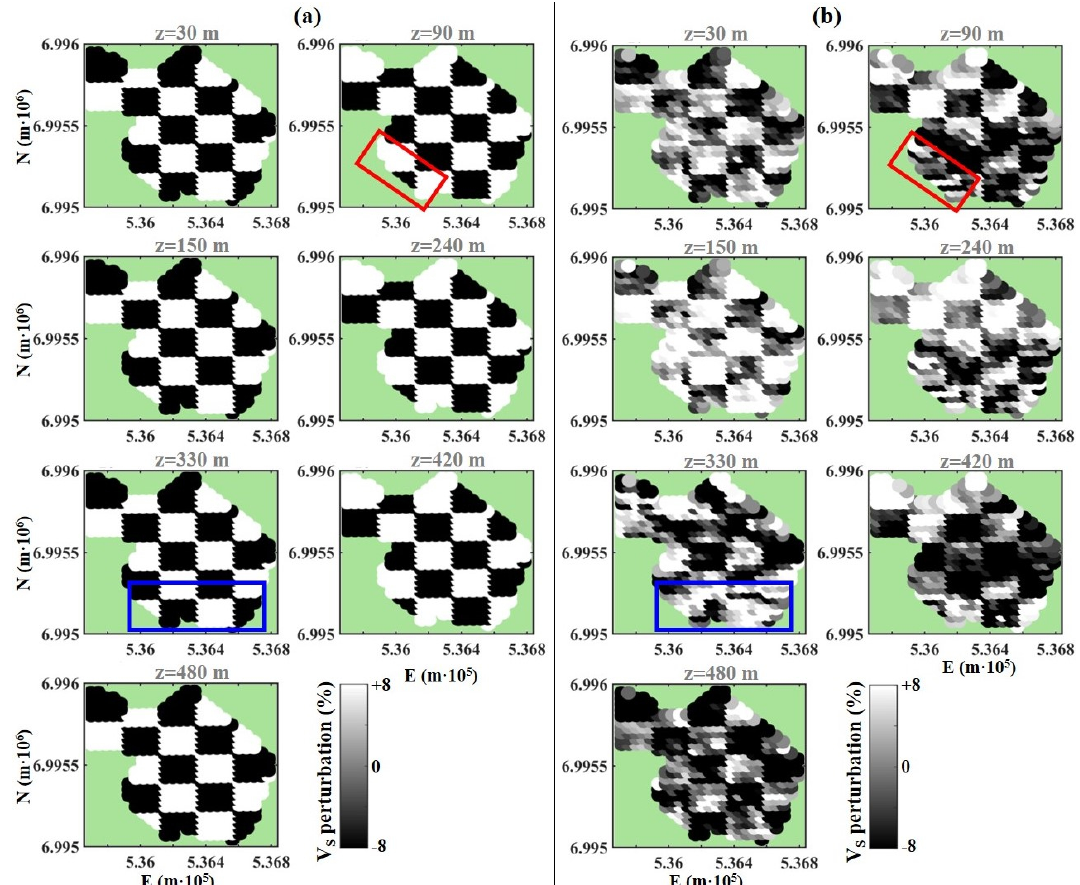
Figure 11. (a) True and (b) inverted checkerboard velocity perturbation. The boxes indicate velocity perturbations which could not be accurately